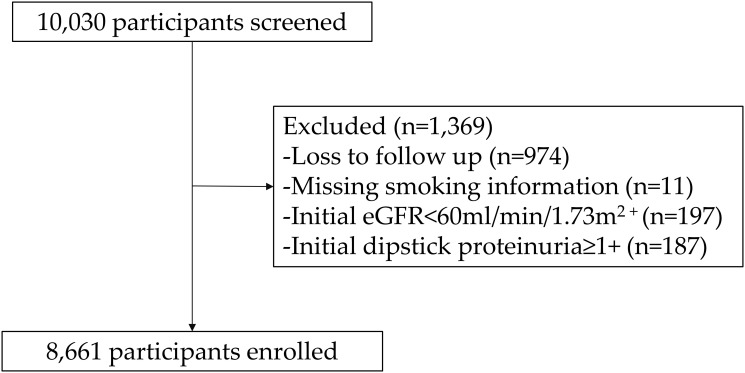
Flow diagram of the study cohort.Abbreviation: eGFR, estimated glomerular filtration rate.